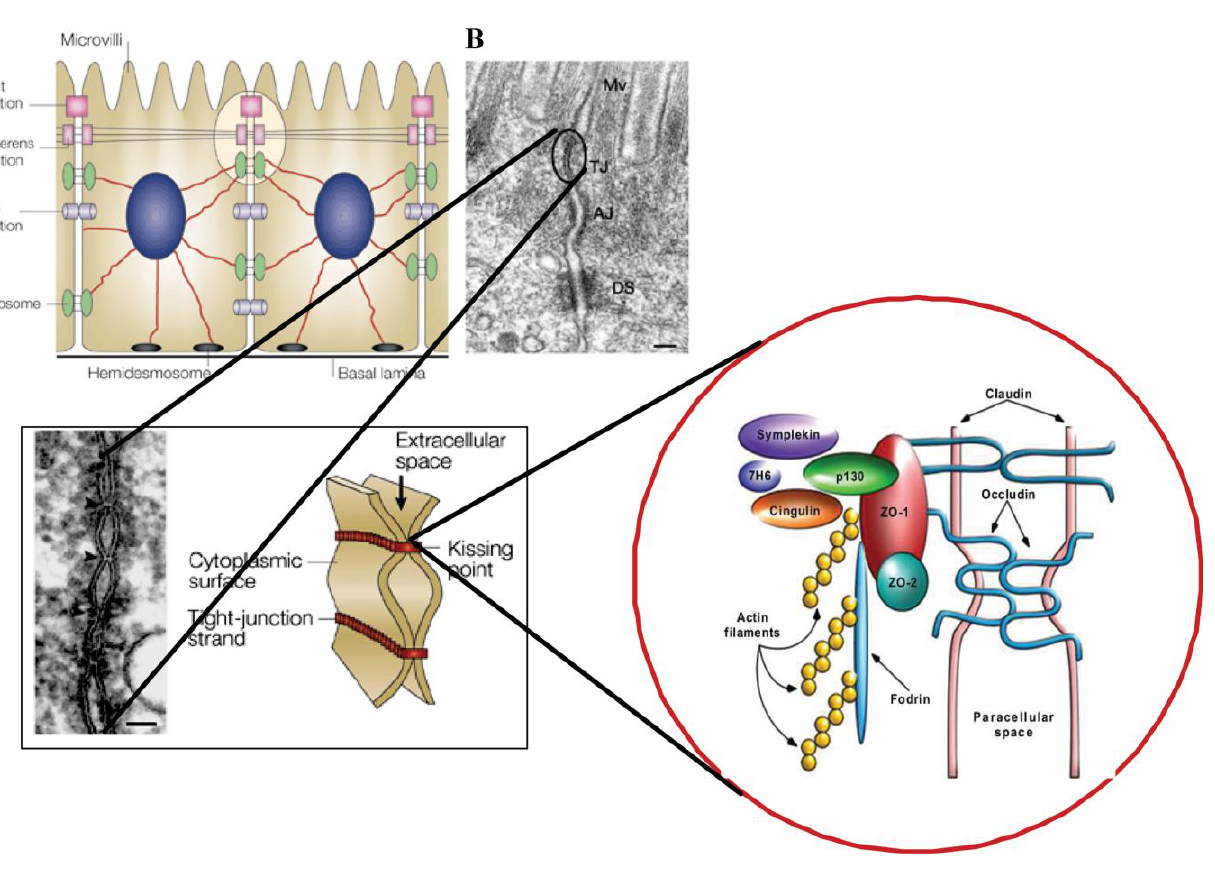
Figure 1. ( A ) Macroscopic arrangement and ( B ) microscopic composition of intercellular tight junctions; reproduced with permission from John Wiley and Sons